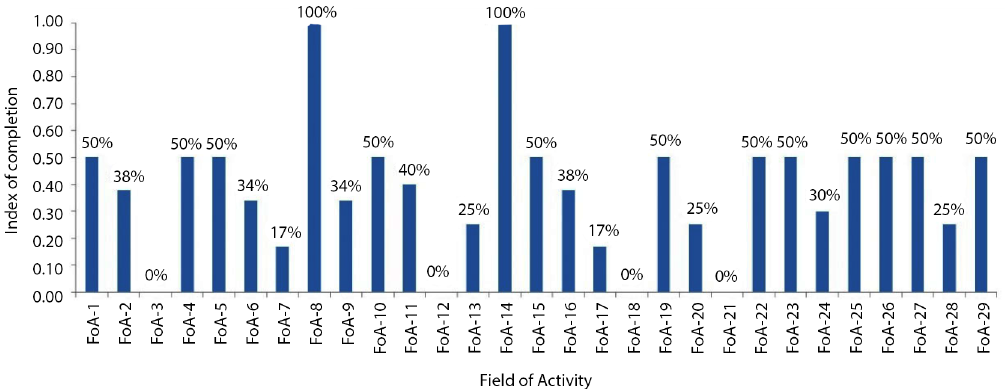
Figure 8. Detailed assessment of each field of activity in the life-cycle of